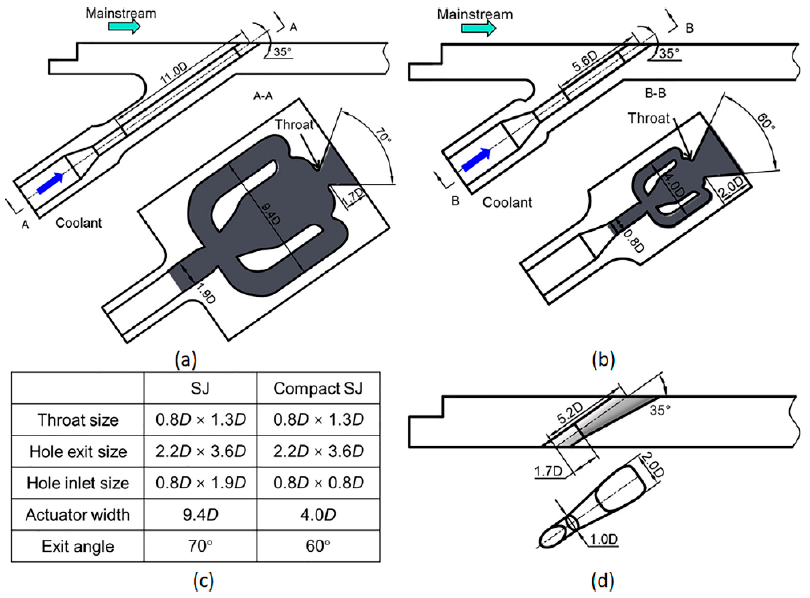
Figure 22. Synthetic Jet (SJ) and 7-7-7 holes used by Zhou et al. [133].